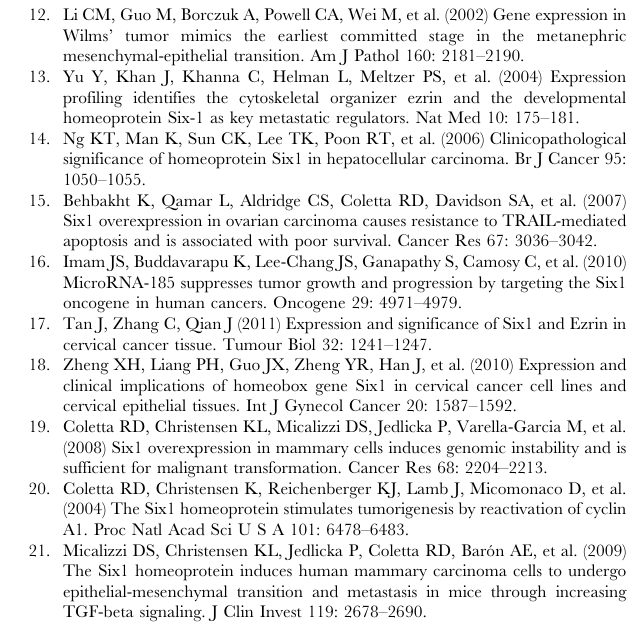
(TIF) Figure S2 The effect of Six1 siRNAs on the endogenous expression levels of Six1 was examined in PANC-1 and MIA PaCa-2 cells by quantitative PCR (A and B) and western blot analyses (C and D). GAPDH was used as an internal control. All the experiments were performed in triplicate; bars, s.e.m.; * P , 0.05. (TIF) Figure S3 Six1 correlates with cyclin D1 in the xenograft tumors from PANC-1 cells stably transfected with either Six1 or control plasmids as determined by western blot and then quantified by Fluorchem computer analysis (r =0.721, P =0.023). (TIF) Figure S4 Analyses of expression of various cyclins by Western blot in two stable cell lines ectopically overex- pressing Six1: PANC-1 (A) and MIA PaCa-2 (B) cells. GAPDH was used as an internal control.